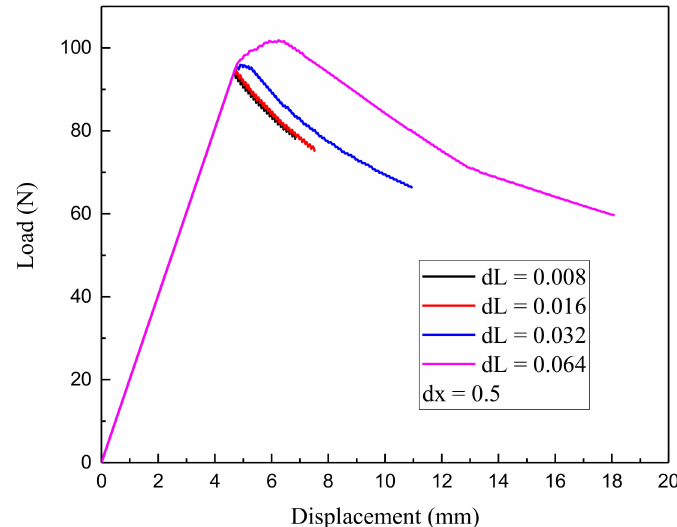
Figure 8. Convergence analysis of loading increment dL for grid spacing dx = 0.5 mm, PD modeling